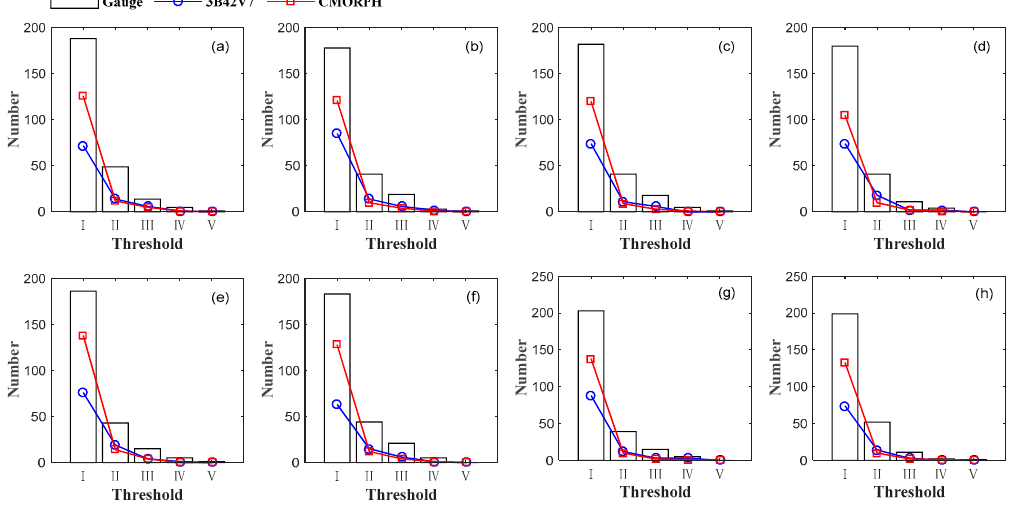
Figure 3. The detection results of different rainfall thresholds (( a – h ) indicate that the gauge ID in Table 1).